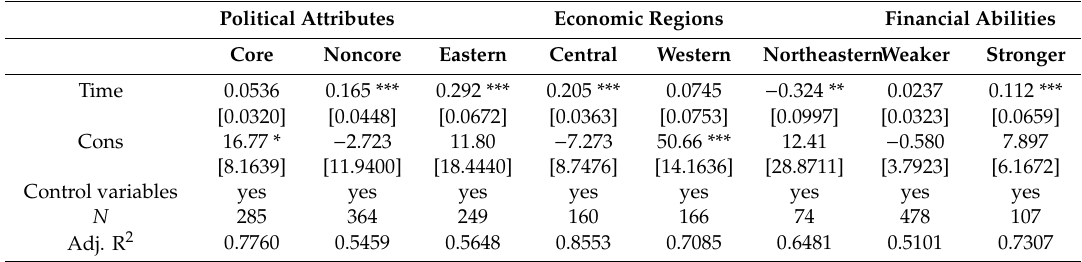
Table 8. Test of the e ff ect of the HSR development under di ff erent types of heterogeneity. Political